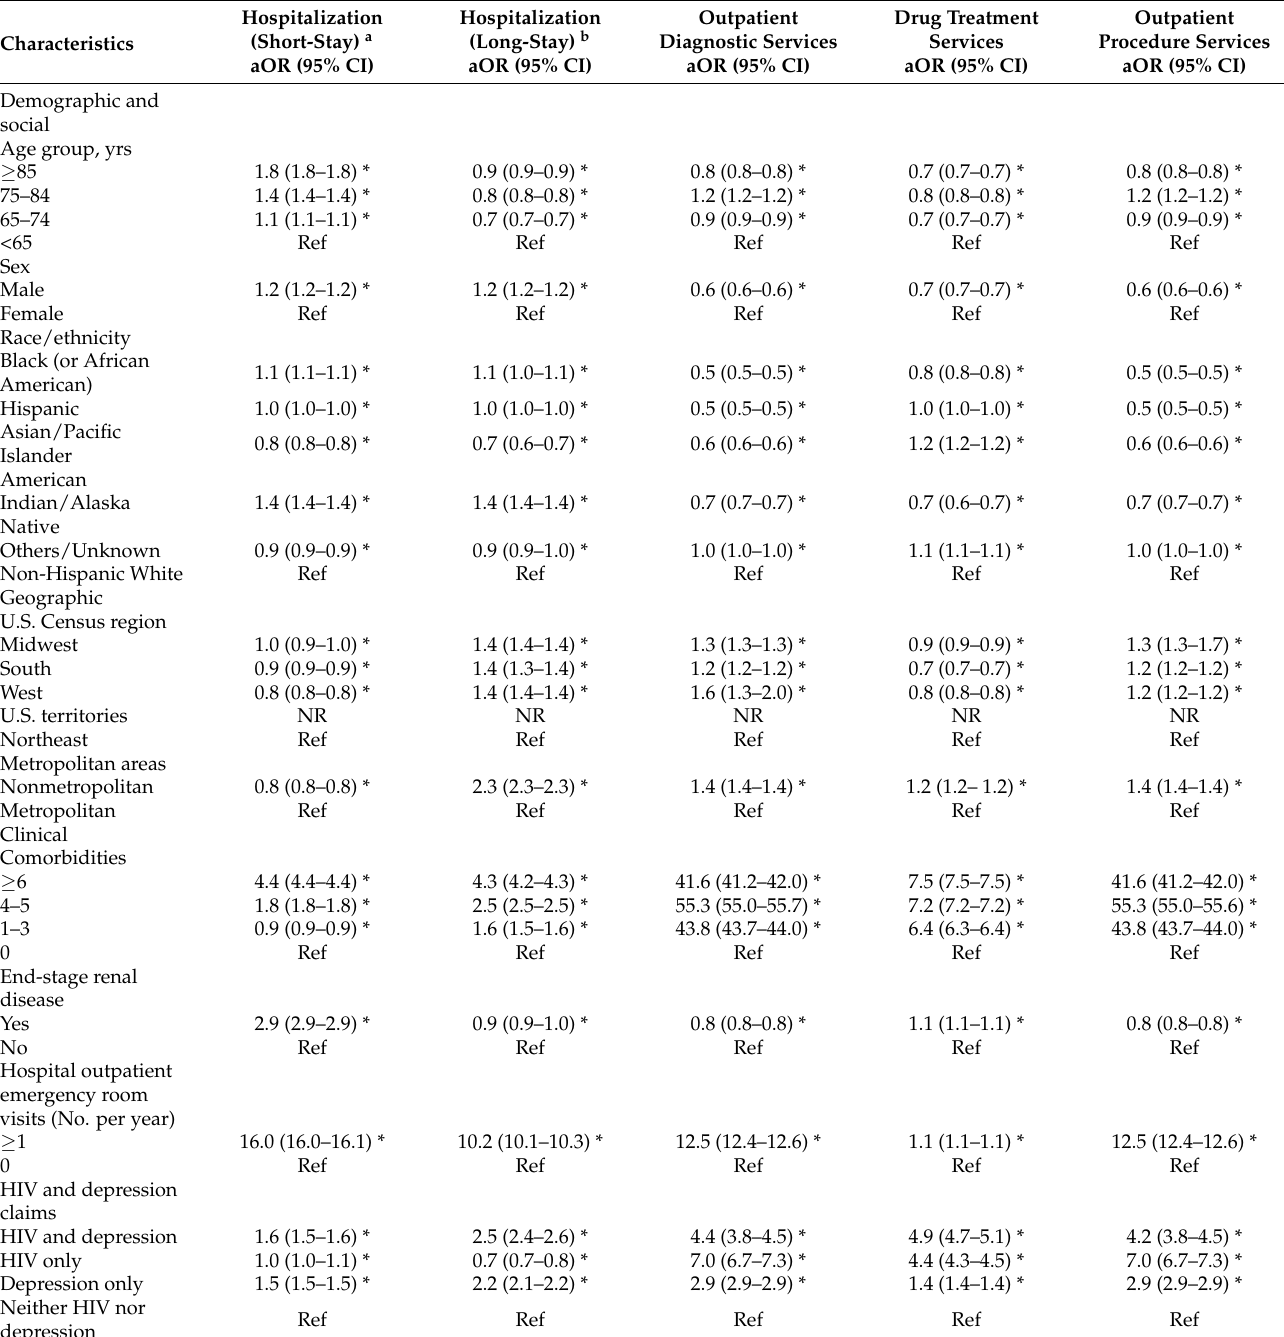
Table 3. Association of health care services utilization with HIV and depression fee-for-service claims among Medicare beneficiaries, United States,